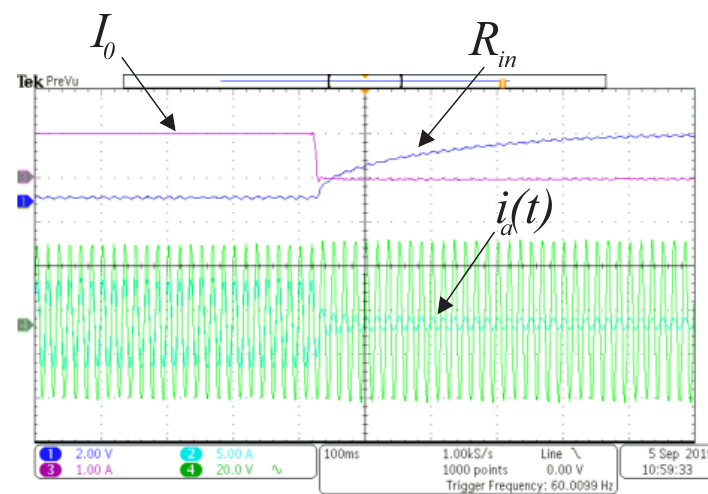
Figure 23. R in controller (5 Ω /V) (2 V/div), DC-link current (1 A/div), grid voltage (20 V/div) and phase current (5 A/div) for the PWM rectifier transient from high-load to no-load. Hor 40 ms/div.